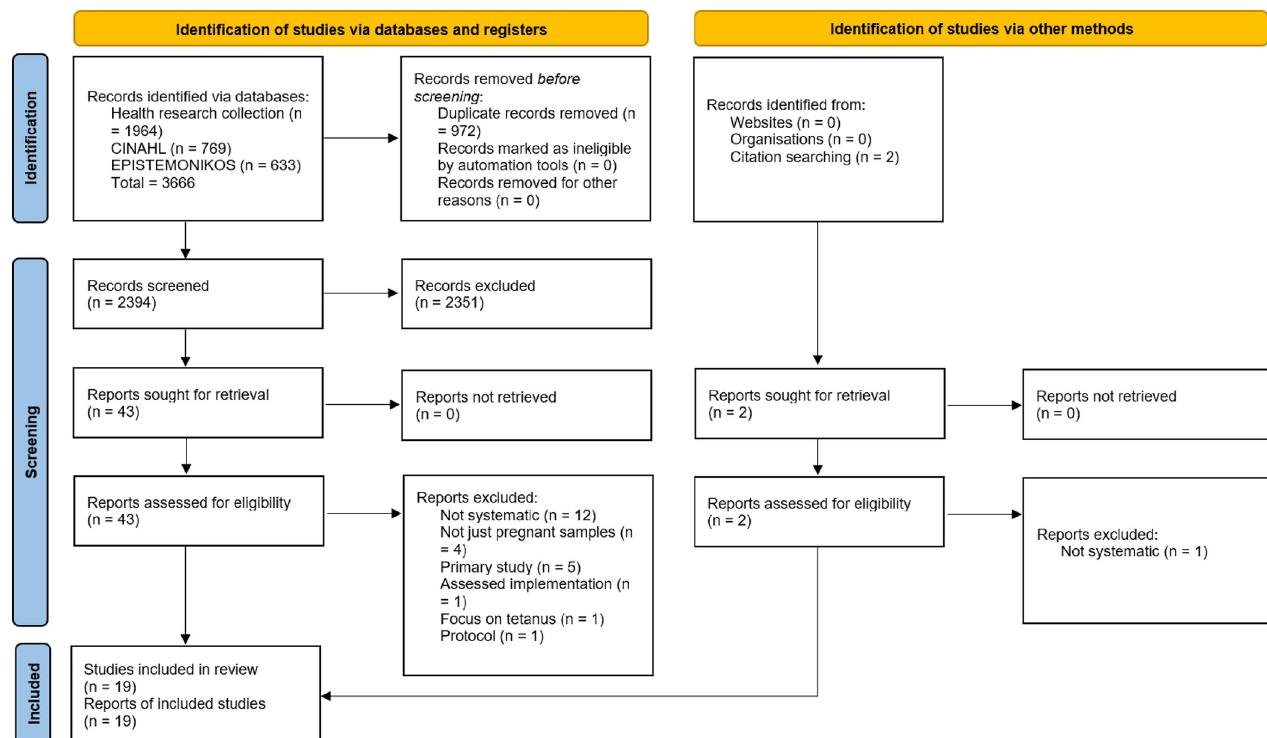
Fig 1. PRISMA 2020 diagram (Page et al., 2021), illustrating the exclusion process and distinguishing between article sources.